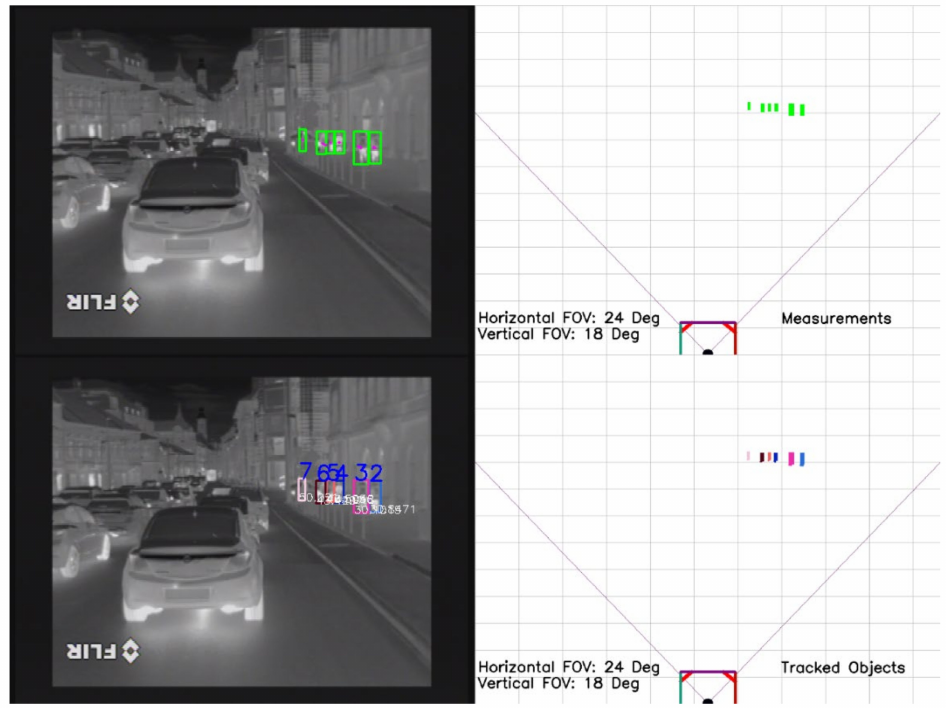
Figure 7. Multiple pedestrians are tracked. No ID switch appears among the tracked